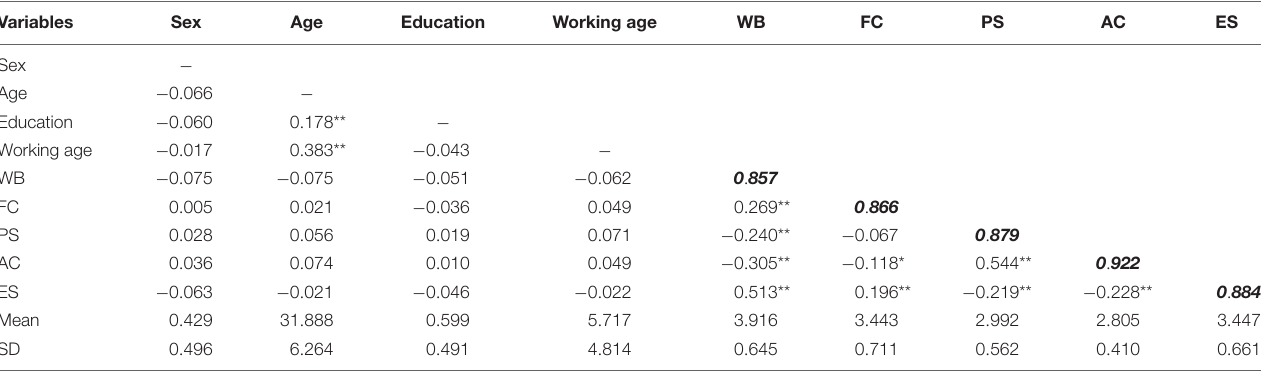
TABLE 1 | Descriptive statistics and correlation analysis of each variable.